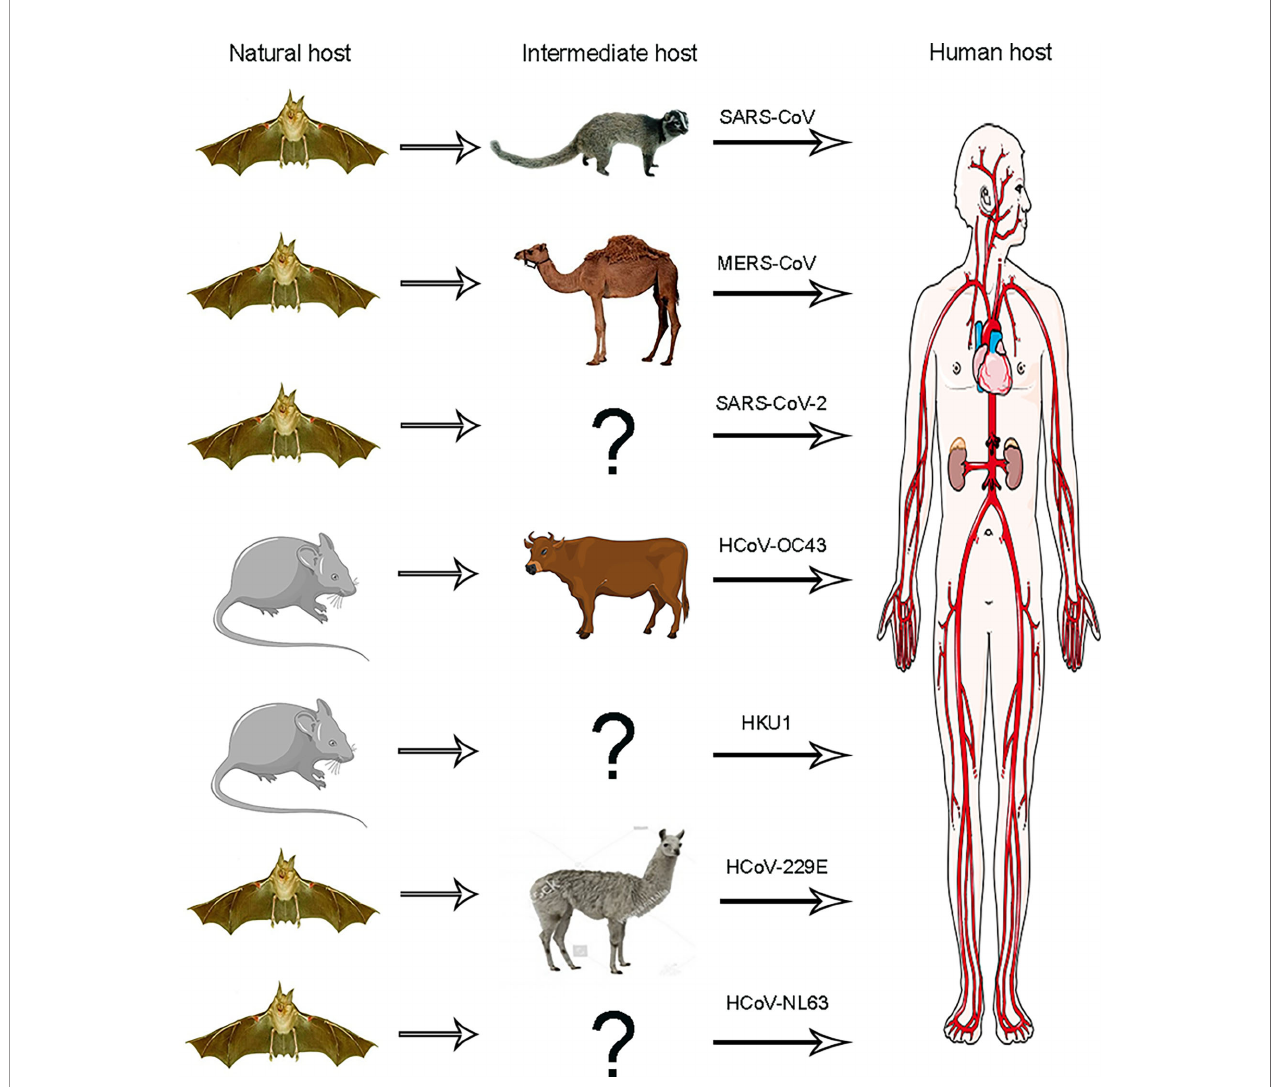
FIGURE 2 | Animal origins of human coronaviruses. SARS-CoV, MERS-CoV, and SARS-CoV-2 originated from bats; HCoV-229E and HCoV-NL63 usually lead to mild infections in immune people. The origins of these viruses have recently been found in African bats, and camelids may be intermediate hosts of HCoV-229E, HCoV-OC43, and HKU1, all of which are also harmless in humans and probably originated from